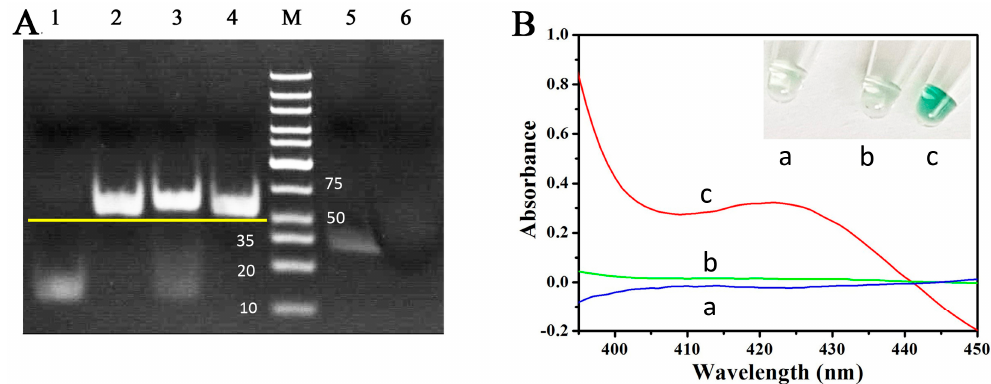
Figure 1. ( A ) Native PAGE analysis of the feasibility of TdT-assisted tailing. Lane 1, T1; lane 2, P1; lane 3, mixture of T1 and P1; lane 4, P1 incubated with 5 U Ac II; lane 5, mixture of T1 and P1 incubated with 5 U Ac II; and lane 6, mixture of T1 and P1 incubated with 5 U Ac II, 100 mM dCTP, and 10 U TdT. ( B ) Colorimetric detection in the solution containing hemin (0.6 µ M, 10% DMSO), H 2 O 2 (2 mM), ABTS (2 mM), and KCl (10 mM), (a) blank control, (b) in the absence and (c) in the presence